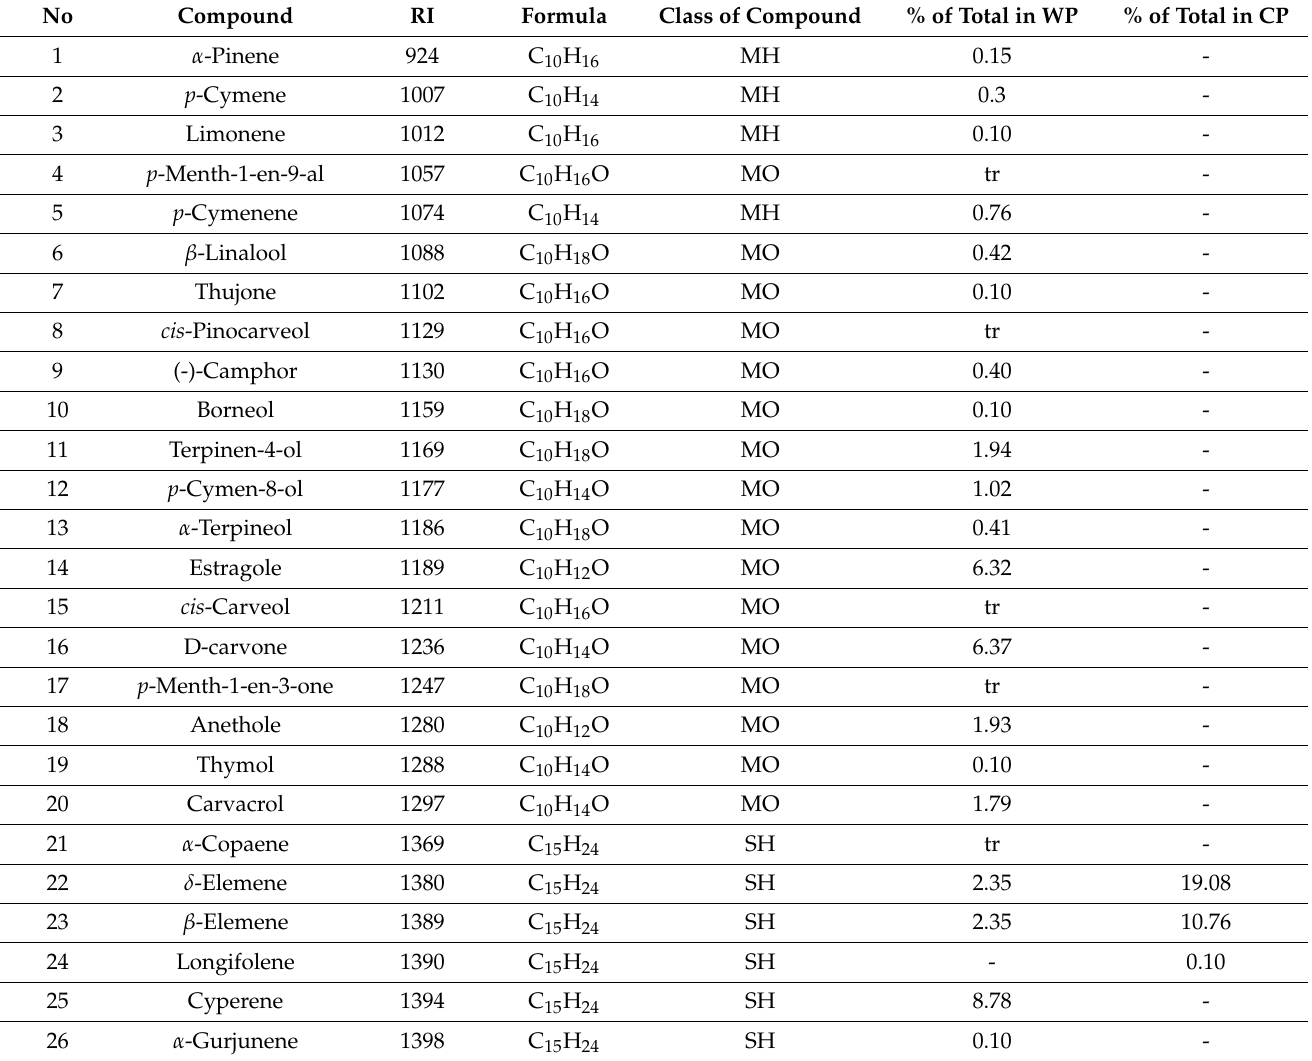
Table 1. Volatile organic composition of R. carthamoides isolated EO from wild-grown population (WP) and cultivated in Bulgaria population (CP) as a percentage of total EO, tr—trace (less than 0.05%), “-”—not detected compounds. The percentage distribution of the main terpene classes identified in the analyzed EOs is summarized at the end of the